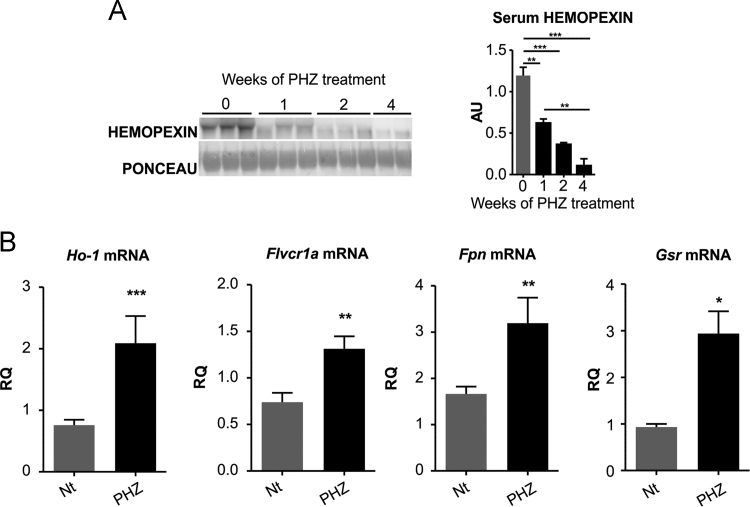
PHZ-treated mice show an alteration of heme- and oxidative stress-responsive genes in the heart. (A) Western blot of serum Hx of untreated (0) or PHZ-treated Wt mice at 1, 2 or 4 weeks of treatment. (B) qRT-PCR analysis of Ho-1, Flvcr1a, Fpn, Gsr, mRNA levels in the heart of untreated or PHZ-injected mice after 4 weeks of treatment. In A, one-way ANOVA with Bonferroni post-test analysis was performed; in B, unpaired t-test analysis with Welch׳s correction was performed. *P < 0.05; ** P < 0.01; ***P < 0.001.